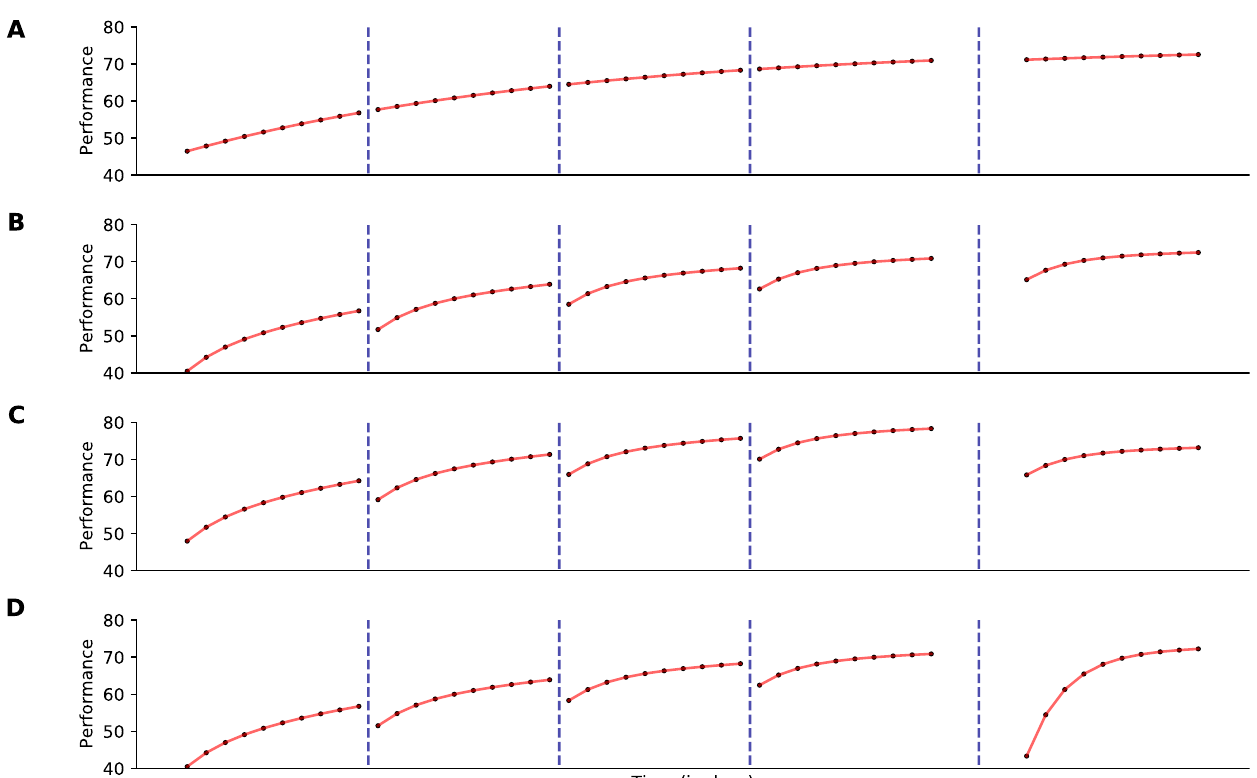
Fig. 3 Model predictions for a hypothetical experiment with fi ve sessions of practice and ten games in each session. Dashed lines separate sessions. All sessions are spaced 1 day apart except for the fi nal session, which occurs 300 days after the previous session. Panel A shows predictions for M 1 , panel B for M 2 , panel C for M 3 , and panel D for M 4 . The parameters used to generate model predictions are A = 75, U = 30, λ = . 05, γ = 0.008, β = 0.5, δ = 0.25, and τ =